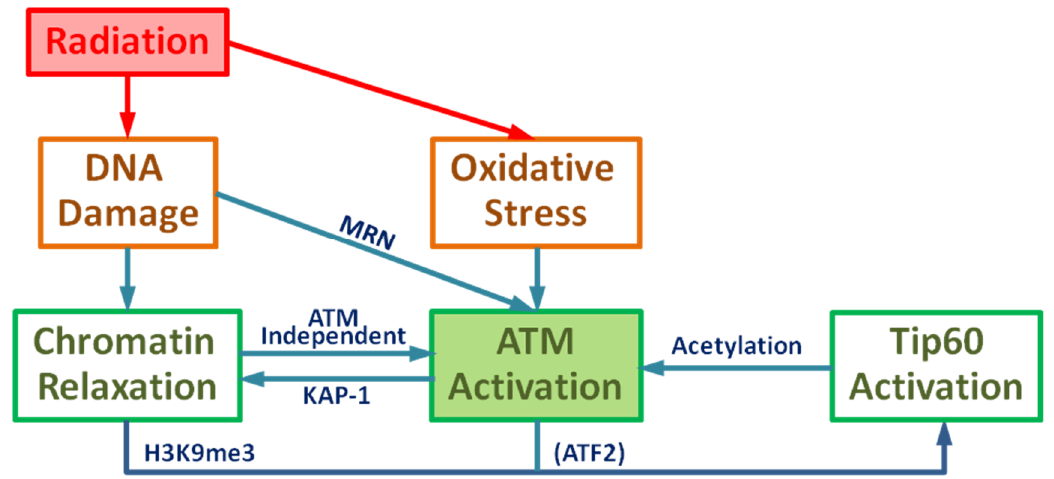
Figure 1. Schematic diagram of Ataxia-telangiectasia mutated (ATM) activation: Ionizing radiation leads to DNA damage and oxidative stress resulting in the activation of ATM and chromatin relaxation.